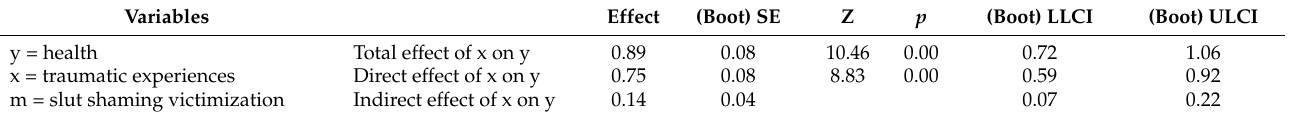
Table 4. Mediation analyses—Predictors of health problems.